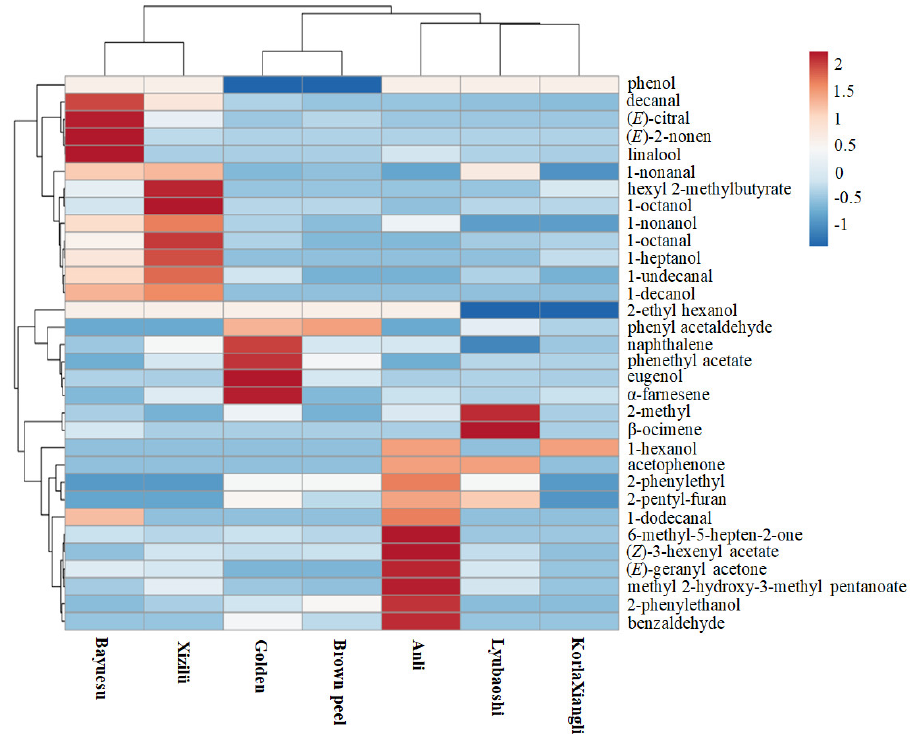
Figure 6. Hierarchical clustering heatmap of selected odorants in flowers of seven pear cultivars. Each colored cell on the map corresponds to OAVs of the odorants, with the samples in the rows and compounds in the columns.